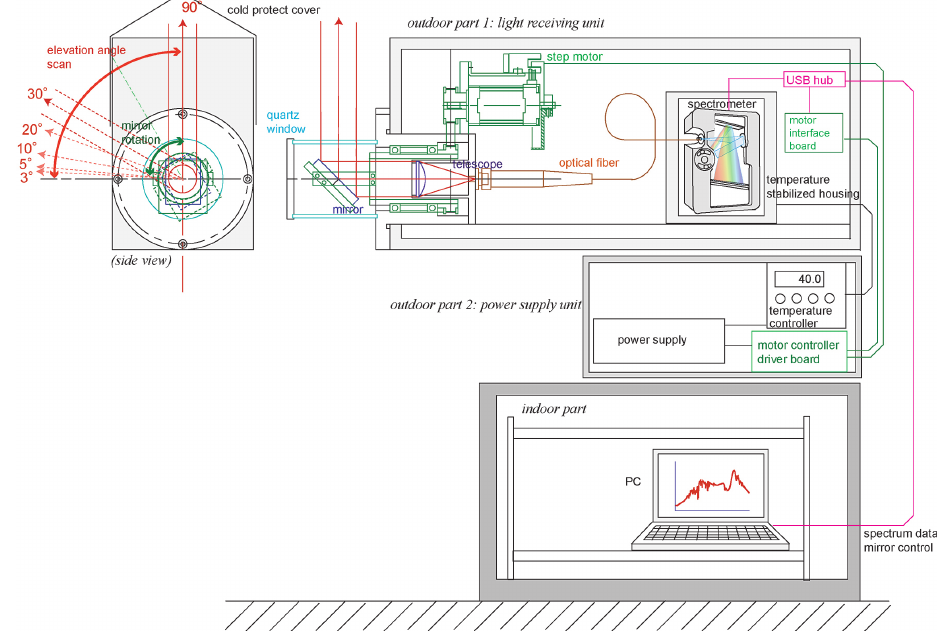
Figure 1. Schematic diagram of the MAX-DOAS instrument used at Zvenigorod.